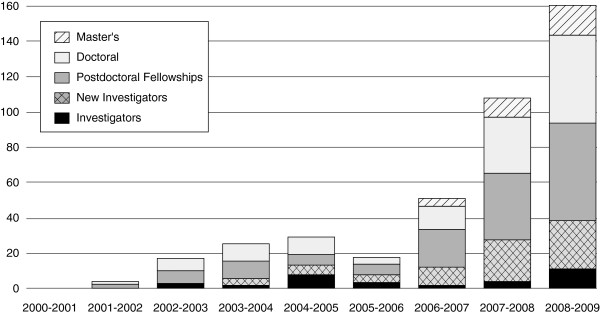
Number of health systems and services CIHR-funded training and salary awards, by year.